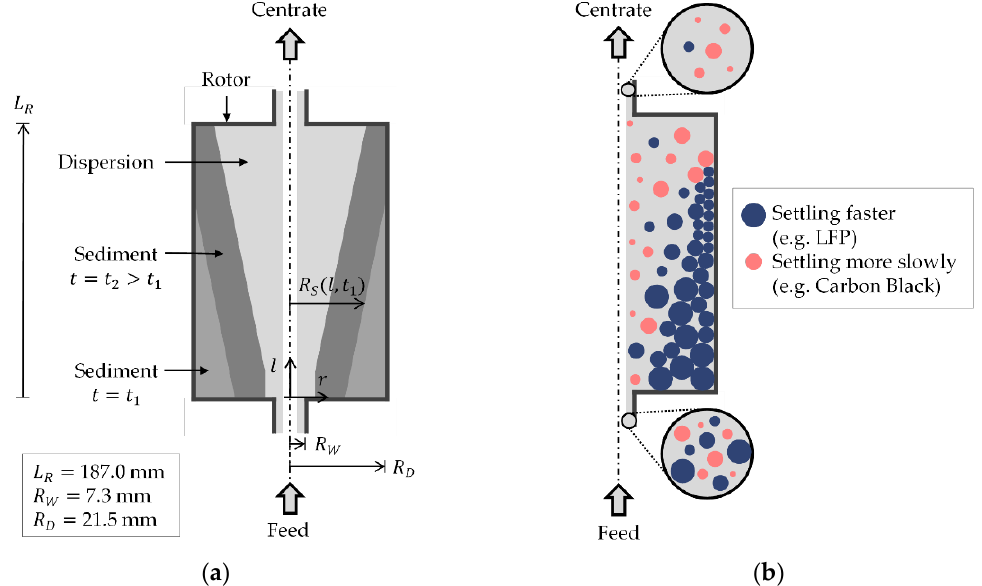
Figure 1. Schematic illustration of the tubular centrifuge and particle sedimentation, in cross-sectional view. ( a ) Tubular centrifuge with geometrical dimensions and progressive sediment build-up. Geometry data given for CEPA Z11; ( b ) Particles in the centrifuge (particle sizes exaggerated): Feed dispersion containing two particle systems, specific settling behavior and sediment build-up for almost complete fractionation, centrate containing nearly solely the particle system settling more slowly (Blue: Faster-settling component, representing LFP; Red: Component settling more slowly, representing carbon black).